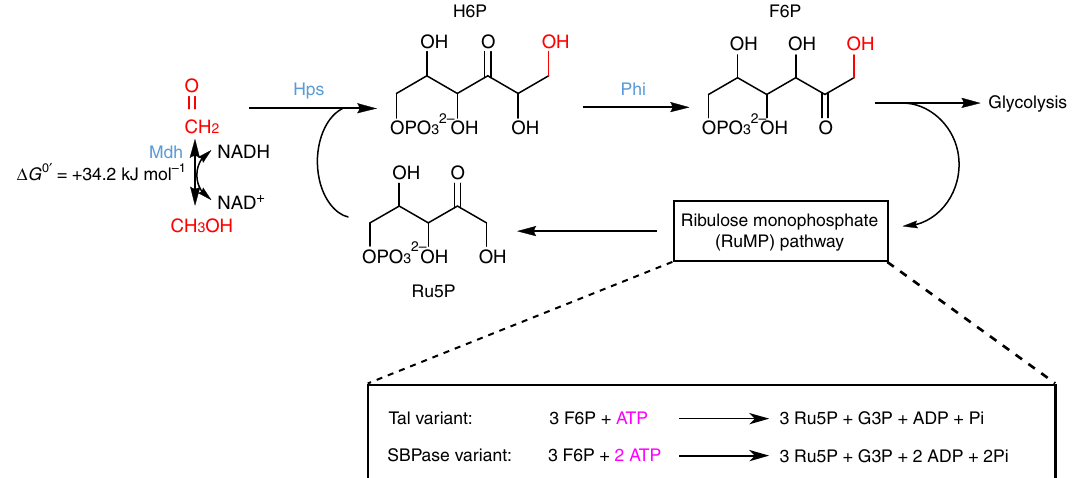
Fig. 1 The pathway of methanol assimilation in E. coli . Heterologous enzymes required for methanol assimilation in E. coli are shown in blue. Methanol dehydrogenase (Mdh) catalyzes the thermodynamically uphill NAD-dependent oxidation of methanol to formaldehyde ( Δ G 0 ′ = + 34.2 kJ mol − 1 ), which is ligated to ribulose 5-phosphate (Ru5P) in an aldol reaction catalyzed by hexulose phosphate synthase (Hps). The resulting hexulose (H6P) is isomerized by phosphohexulose isomerase (Phi) to fructose 6-phosphate (F6P), which is metabolized through native E. coli central metabolism. A portion of the F6P must be used to regenerate Ru5P through the ribulose monophosphate (RuMP) cycle to enable further formaldehyde assimilation. Two major variants of this cycle are known, the transaldolase (Tal) and sedoheptulose bisphosphatase (SBPase), which are named for the enzyme that produces sedoheptulose 7-phosphate, and differ in their ATP requirements. The red moiety denotes the position of assimilated methanol. H6P: D -arabino-3-hexulo-6-phosphate, G3P: glyceraldehyde